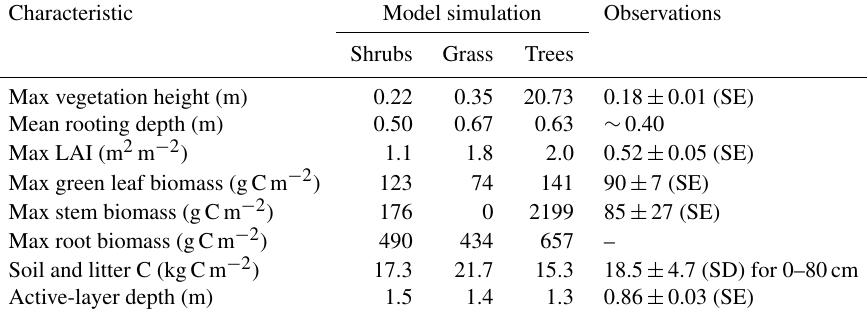
Table 4. Vegetation and soil characteristics observed at the Daring Lake tundra (DL1) research site and modelled for this site using three simulations of CLASSIC with different plant functional types and the new ground evaporation efficiency parameterization. Observations of vegetation height, LAI, and active-layer depth at DL1 are described in the Methods section. Mean rooting depth was approximated from visual observations in the field. Biomass was assessed by harvesting all standing living vascular vegetation from three 0.25m 2 plots, sorting by species, and separating leaves and stems. Material was dried at 35 ◦ C to constant weight and converted to C assuming a 2:1 dry weight to C ratio. Soil C was assessed using loss on ignition and elemental C analysis of soil cores from eight random soil